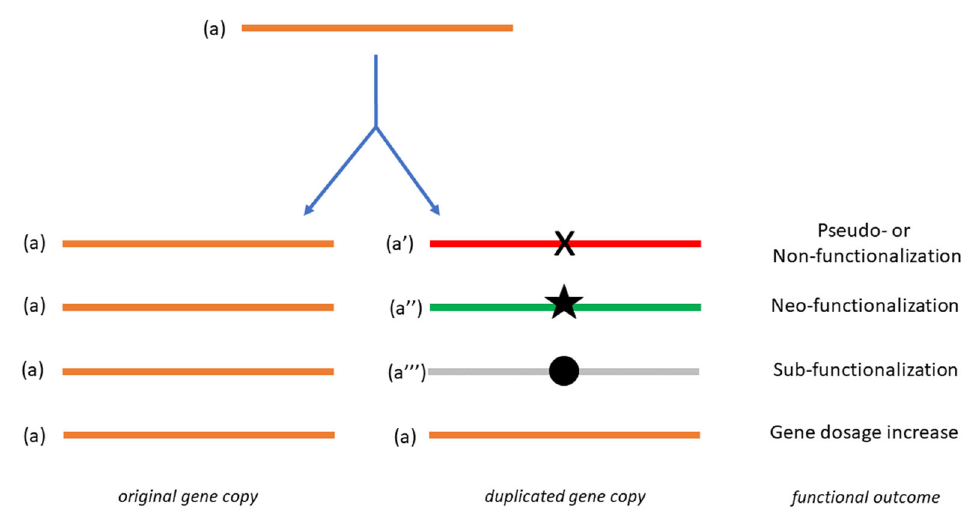
Figure 1. Schematic representation of gene duplication and its consequences. The symbols X, star and full circle denote one or more mutations which, after gene duplication, result in the functional outcomes specified on the right. The functional state of the duplicated gene is highlighted in color (orange, unchanged; red, non ‐ or pseudofunctional; green, neo ‐ functional; grey, sub ‐ functional).